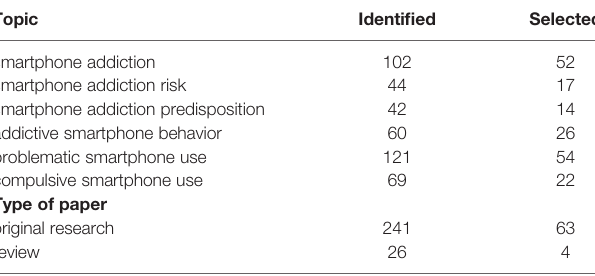
TABLE 1 | Topics and types of papers identi fi ed and selected. Topic Identi fi ed